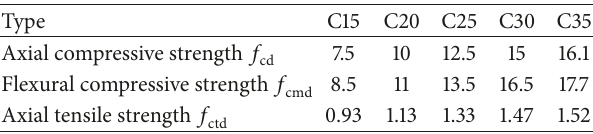
Table 4: Concrete strength grade.